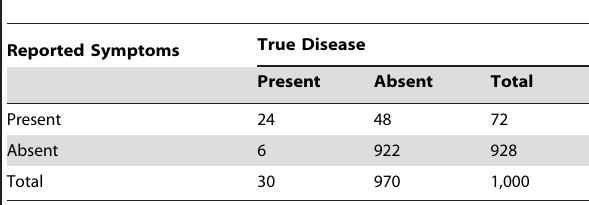
Table 6. Distribution of cases of ‘‘true pneumonia’’ according to caregiver report of ‘‘suspected pneumonia’’ (test) and true disease status when test sensitivity is 80% and specificity is 95% with a four-week recall period.